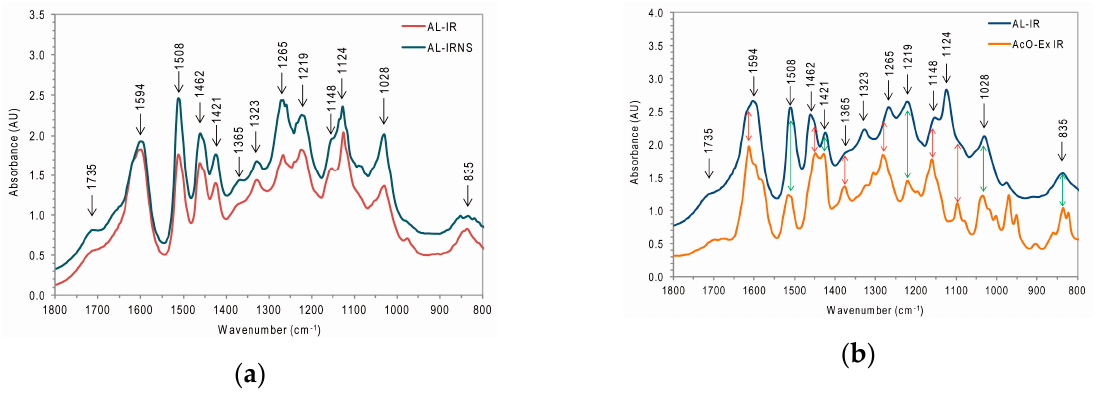
Figure 5. ( a ) FTIR spectra of the isolated acidolysis lignin fractions from Iroko and Iroko–Norway spruce sawdust (AL-IR, AL-IRNS); ( b ) FTIR spectrum of AL-IR compared to the spectrum of the respective acetone-extractives fraction from Iroko sawdust (AcO-Ex IR).